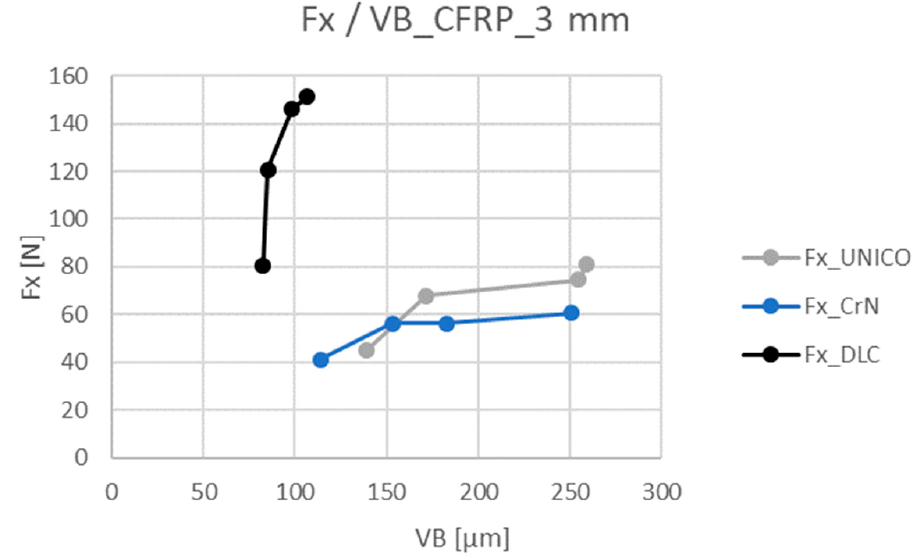
Figure 14. Dependence of the cutting force component F x on wear, laminate thickness 3 mm.